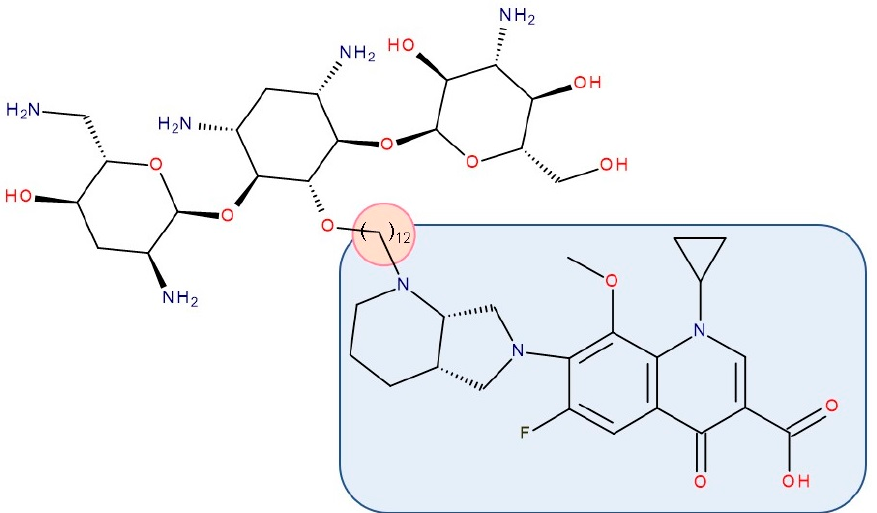
Figure 12. Antibiotic–antibiotic hybrid containing an FQN: tobramycin–linker–moxifloxacin; the linker is highlighted with the orange circle while the QN/FQN unit is highlighted by the blue rectangle [211].